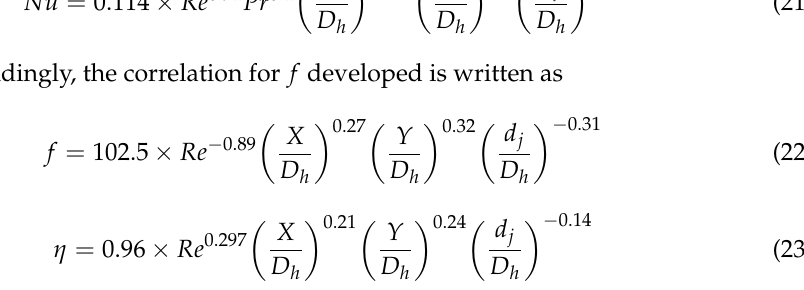
Figure 12. i variation with (cid:8)(cid:9) as a function of ( a ) (cid:19)